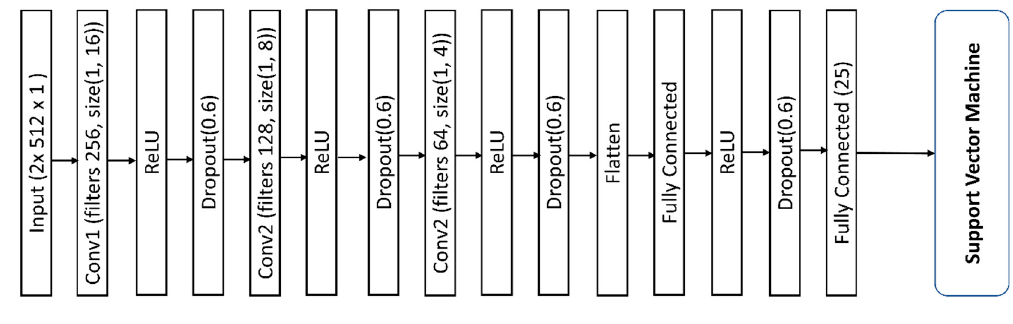
Figure 4. Neural-Induced Support Vector Machine (NSVM) Architecture.